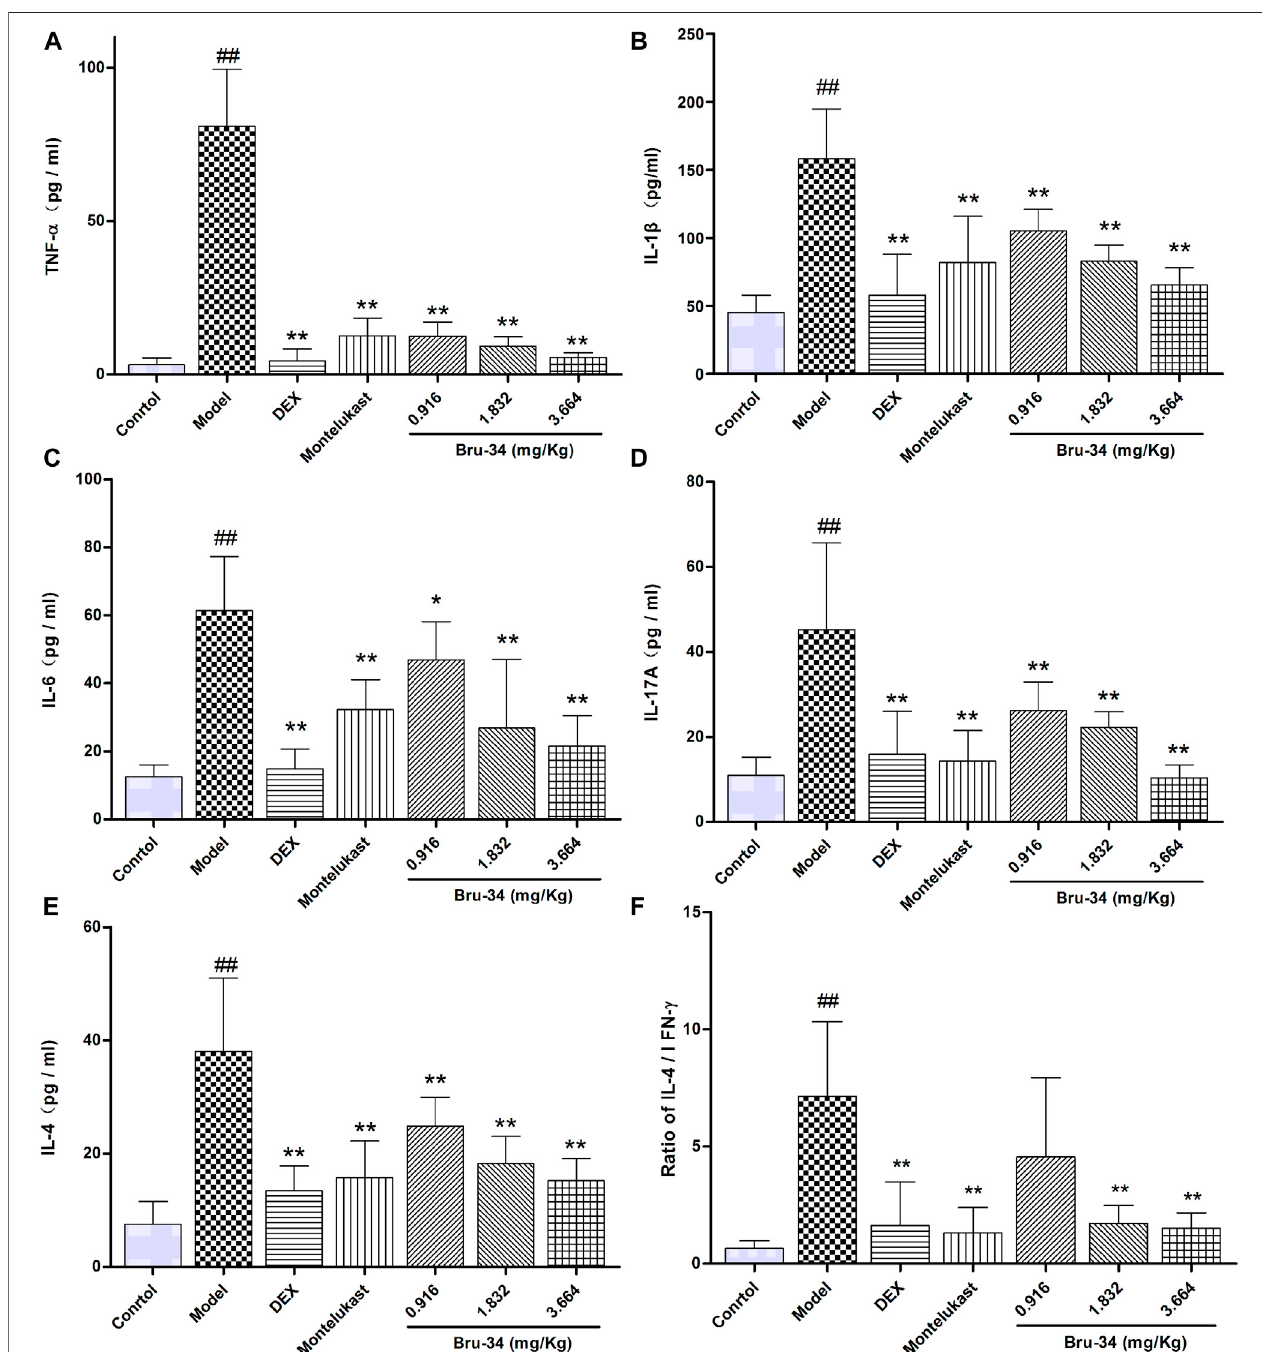
FIGURE3| Theconcentrationsofin fl ammatorymediatorsinBALFweredeterminedbyELISA.Panel (A) :TNF- α ;Panel (B) :IL-1 β ;Panel (C) :IL-6;Panel (D) :IL-17A; Panel (E) : IL-4; Panel (F) : The ratios of IL-4/IFN- γ ; Data were given as mean ± S.D., n (cid:2) 8.